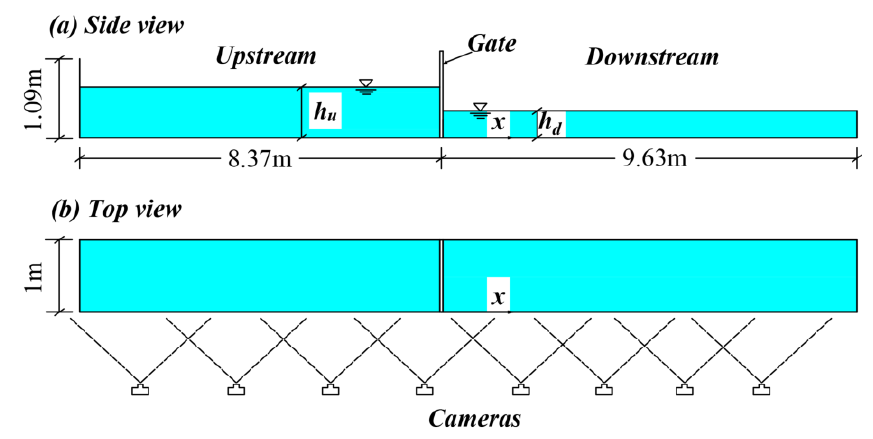
Figure 1. Schematic of the experimental device: ( a ) side view; ( b ) top view